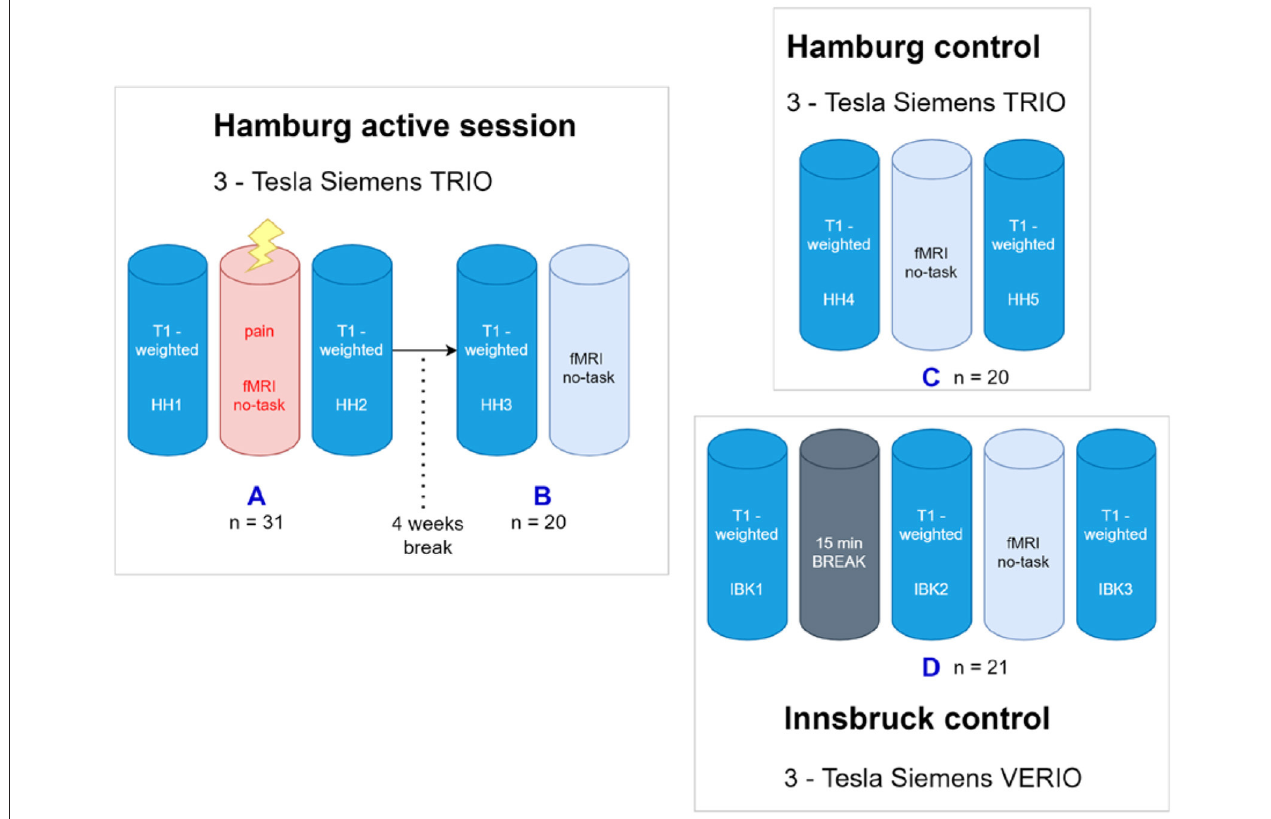
FIGURE 1 | Overview about the project. (A) The first scanning paradigm was carried out in Hamburg using a 3-Tesla Siemens Trio MRI. After T1-weighted image acquisition an fMRI including a nociceptive task was done, again followed by T1-weighted image acquisition. (B) After four wk, the post hoc image acquisition comprised another T1-weighted followed by a (taskless) fMRI session of identical length as the first (painful) fmri session four wk earlier. The control paradigm was carried out using two different, but comparable MRI scans in Hamburg and Innsbruck. (C) The Hamburg control comprised a fMRI acquisition engulfed by two structural T1WI scans. (D) For the Innsbruck control paradigm, three T1-weighted image acquisitions were performed, the first one followed by a rest period without scanning but the participants stayed in the scanner, and, in the same session, the second one with an (again taskless) fMRI session of identical length. SHH1, Sequence 1 at Hamburg Scanner; SIBK1, Sequence 1 at Innsbruck